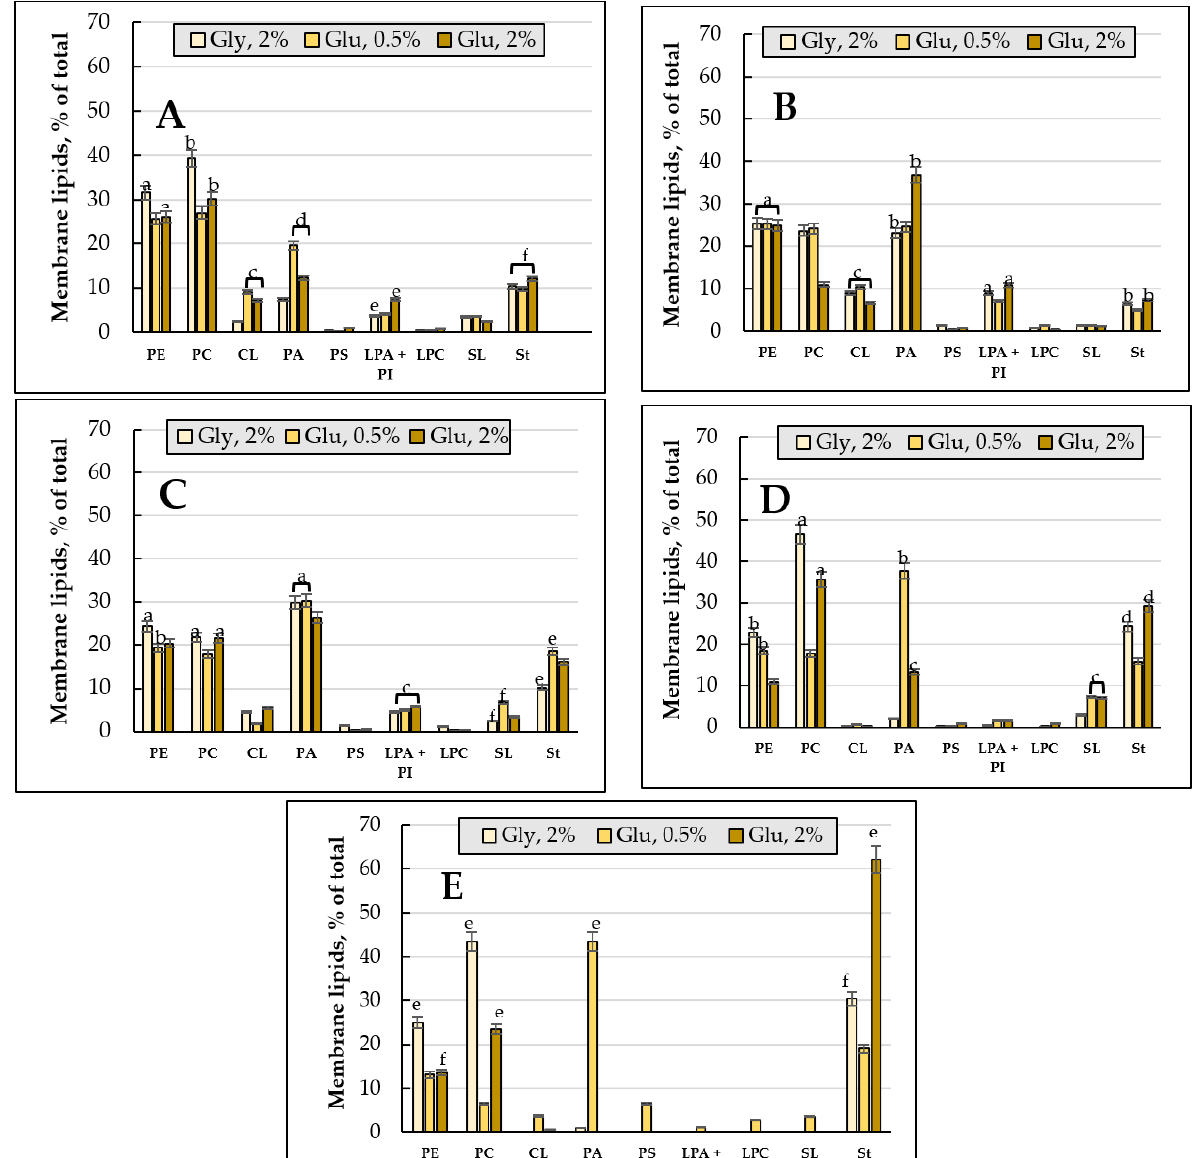
Figure 5. Membrane lipid composition of E.magnusii under different conditions. The share of each membrane lipid fraction, %; ( A ) 24 h of cultivation; ( B ) 1 week; ( C ) 2 weeks; ( D ) 3 weeks; ( E ) 4 weeks. PE—Phosphatidylethanolamines; PC—Phosphatidylcholines; CL—Cardiolipins; PA— Phosphatidic acids; LPA + PI—lysophosphatidylethanolamine + Phosphatidylinositols; LPC— Lysophosphatidylcholines; SL—Sphingolipids; St—Sterols. The conditions of the culture growth are indicated in the panels. Error bars represent the standard deviation of triplicates. Mean values are displayed (n = 3, ±SD). a— p < 0.04; b— p < 0.01; c— p < 0.001; d, e— p < 0.02; f—p < 0.002. The means without letters did not differ significantly.